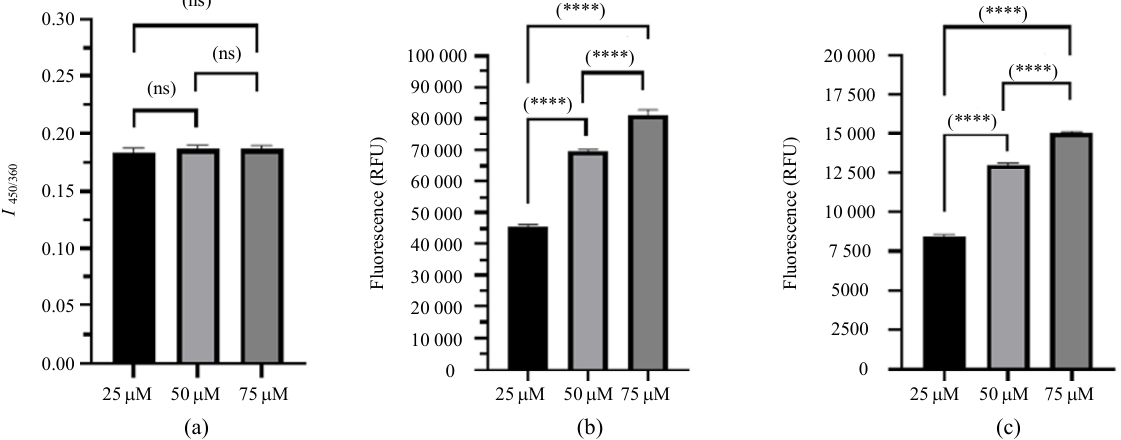
Fig. 8 Concentration effect on ratio I 450/360 at pH:7.20: (a) ratio I 450/360 (emission 520 nm), (b) intensity in 360/520, and (c) intensity in 450/520. **** p <0.0001 statistically significant differences. ns: no significant differences. Data mean ±SEM experiment performed triplicate.